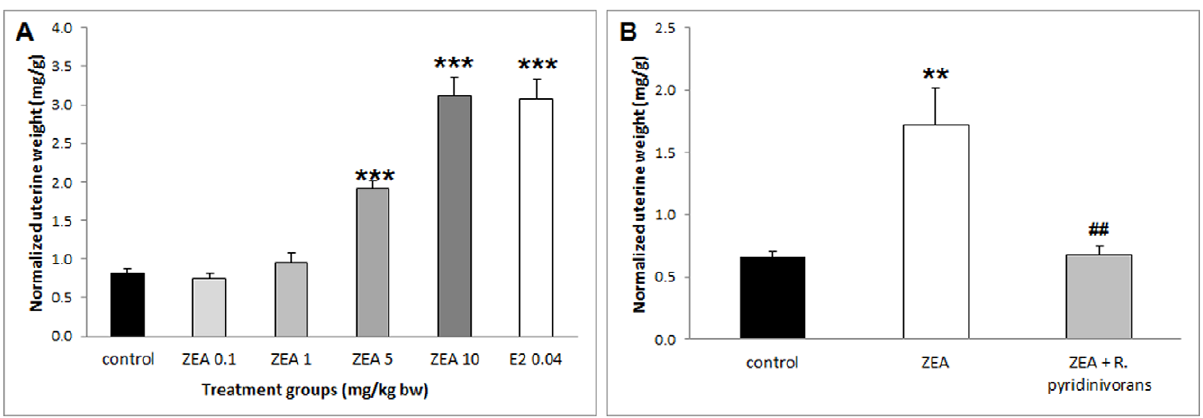
Figure 3. Uterine weights of Experiment1 and Experiment2. Uterotrophic response expressed as relative uterus weight (uterus weight/body weight) in female immature rats after 3-day exposure to E2 (0.04 mg/kg bw) and ZEA (0.1–10 mg/kg bw) ( A, Experiment 1 ) and after 3-day exposure to ZEA-contaminated LB media with and without incubation with R. pyridinivorans K408 ( B, Experiment 2 ). (***) Significantly different from control in Experiment 1 (p , 0.001) (n=6–7). (**) Significantly different from control in Experiment 2 (p , 0.01). ( ## ) Significantly different from ZEA in Experiment